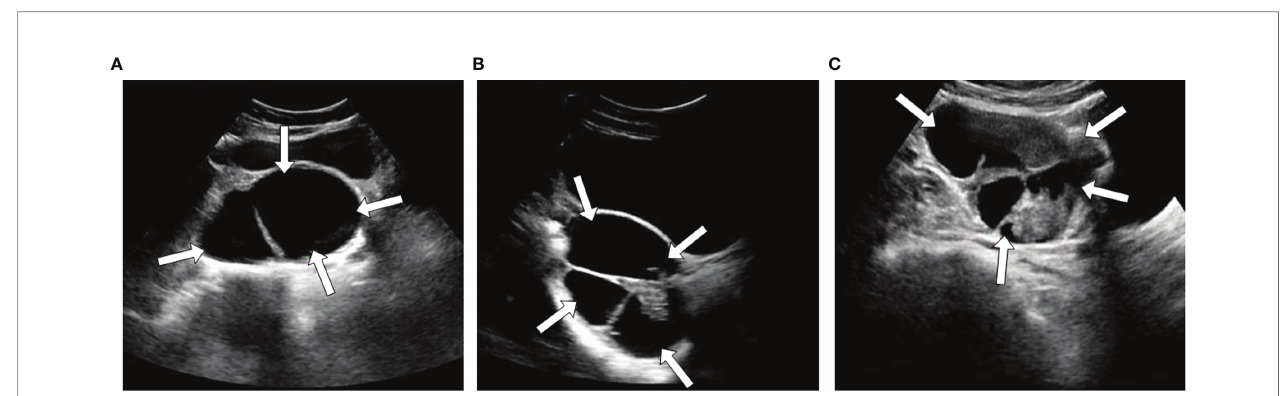
FIGURE 2 | Three examples of ultrasound images with different types SOTs, benign (A) , borderline (B) , and malignant (C)